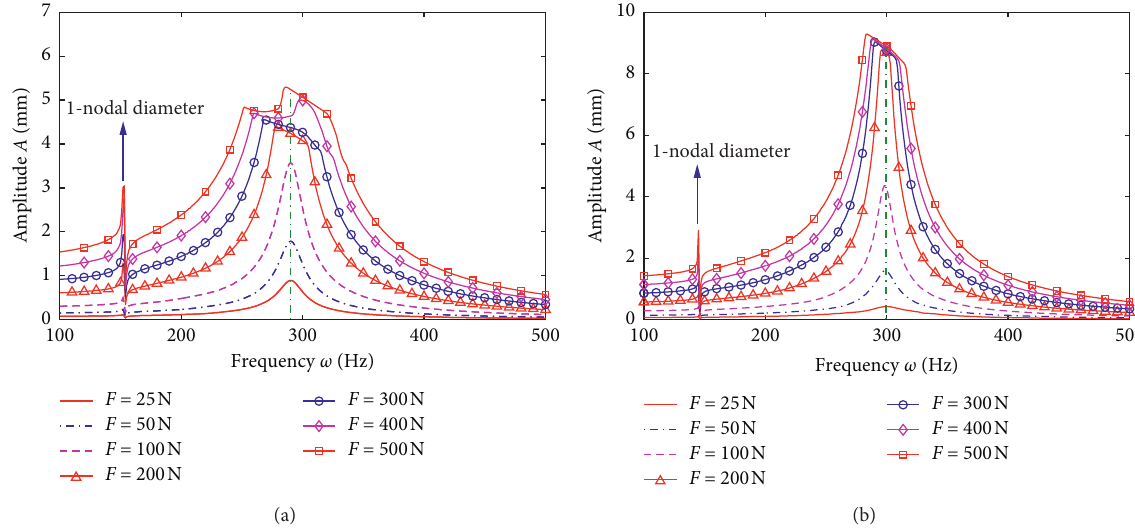
Figure 11: The amplitude-frequency response curve of beam 1 for different excitation levels F : (a) Ω � 200rad/s and (b) Ω � 300rad/s.